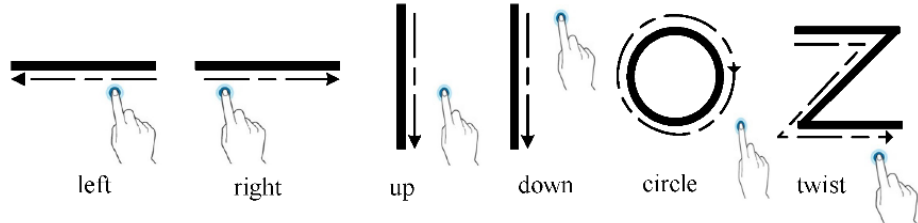
Figure 8. Experimental gestures.